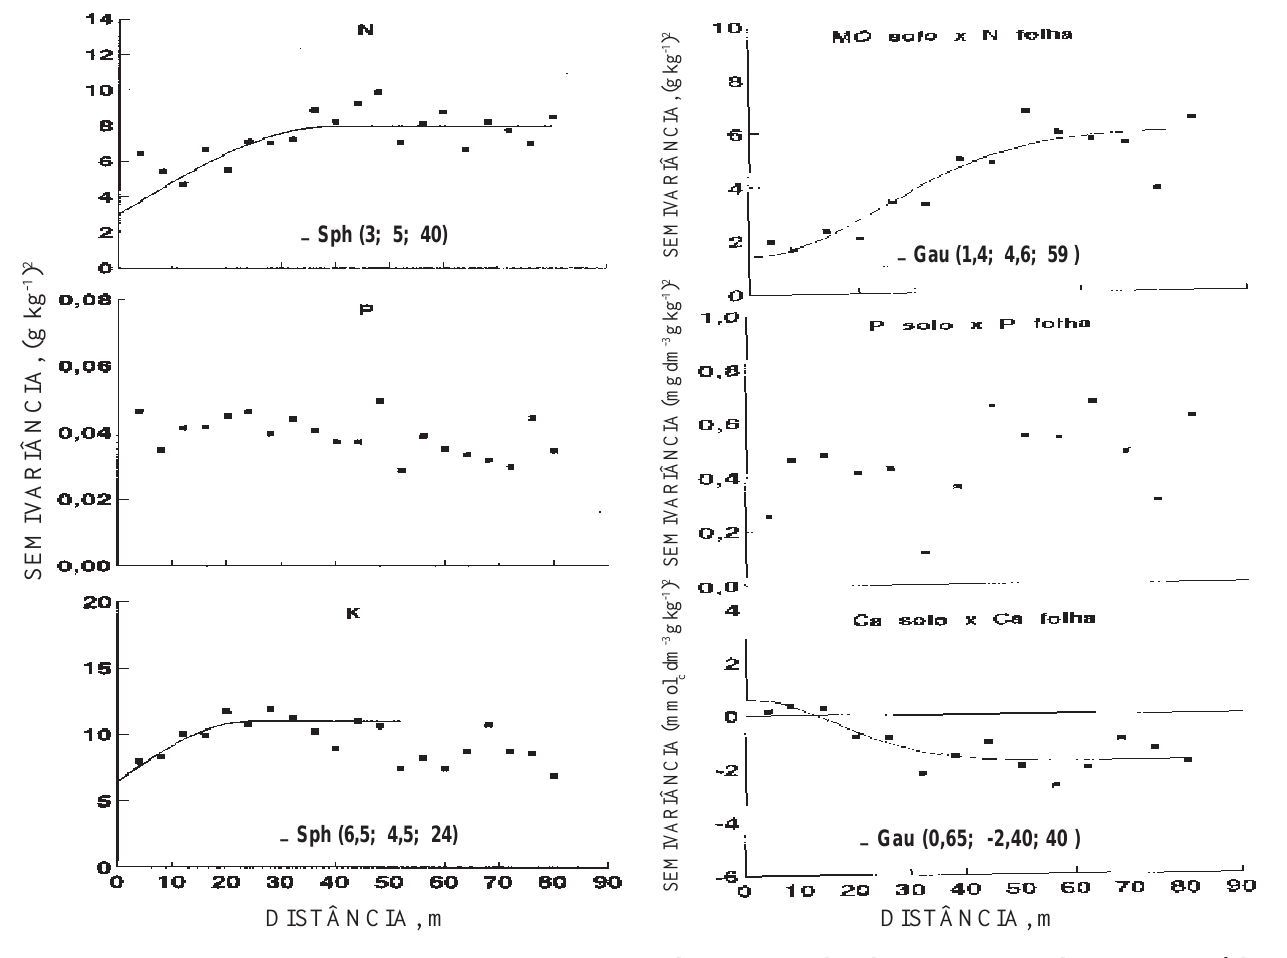
Figura 1. Semivariogramas para N, P e K na folha, na avaliação da variabilidade em um pomar cítrico sob manejo uniforme, em Governador Mangabeira (BA). As legendas incluem o modelo ajustado aos dados (Sph = modelo esférico e/ou Exp = modelo exponencial e/ou Gau = modelo gaussiano) e, entre parênteses, os parâmetros C 0 , C 1 e alcance da dependência espacial; C 0 + C 1 representam o patamar do semivariograma.